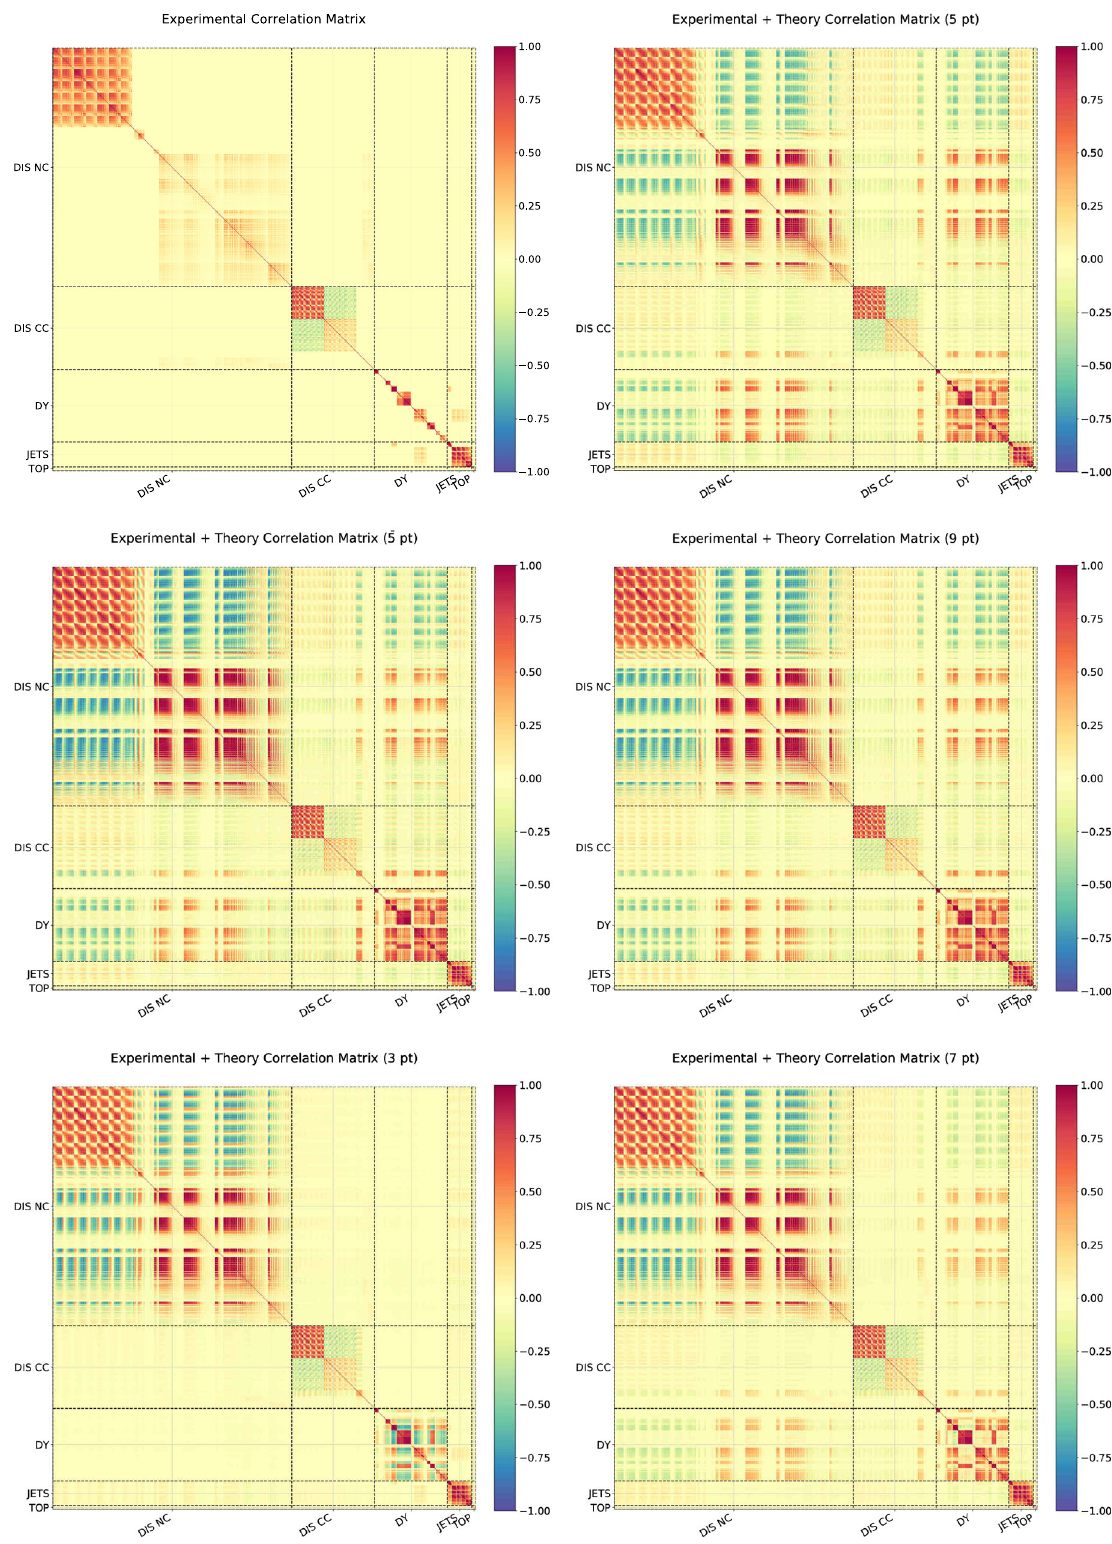
Fig. 7 Comparison of the experimental correlation matrix Eq. (5.1) (top left) and the the combined experimental and theoretical correla- tion matrices Eq. (5.2) computed using the prescriptions described in Sect. 4: the symmetric prescriptions (5-pt top right, 5-pt center left, 9-pt